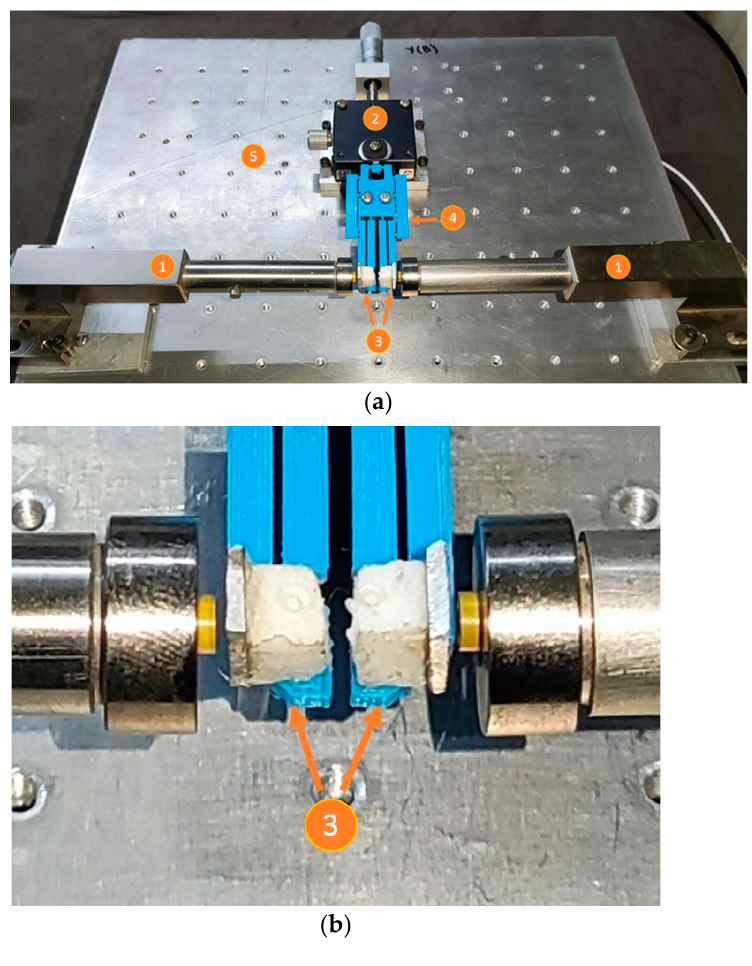
Figure 12. ( a ) Experimental setup for measurement of jaw displacement. ( b ) Zoom-in at the tips of the MG.